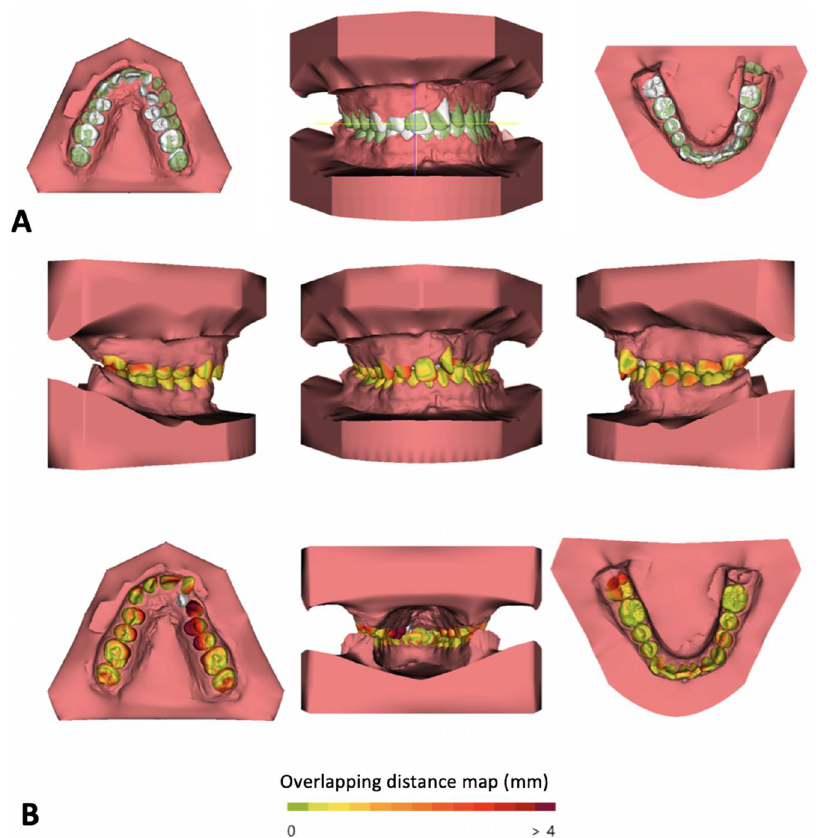
Figure 5. Three-dimensional tooth movement evaluation: Overlapping of the models before and after maxillary expansion- contacts after expansion represented in green color ( A ). Superimposition of models using a distance map ( B ).